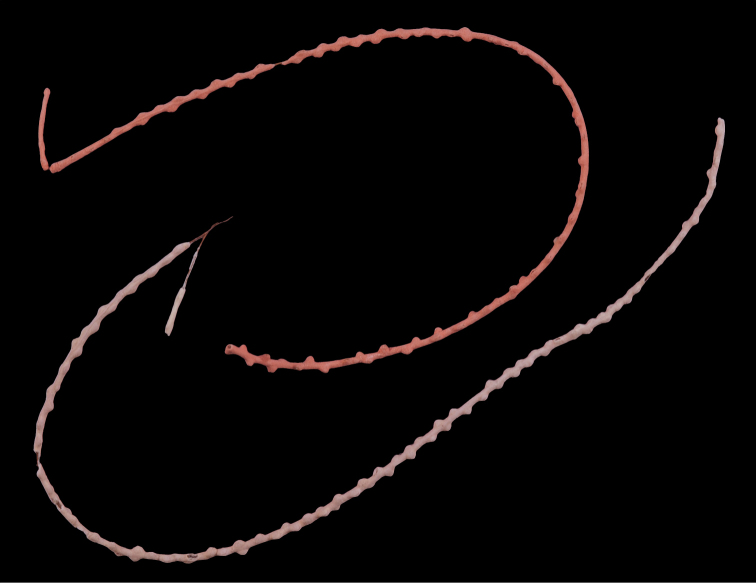
Leptogorgiafilicrispa, SBMNH 423057-Holotype. Two single strands, each showing a different pink color variant. Image originally published as figure 1B in Horvath (2011, Proceedings of the Biological Society of WA 124: 1, 47).